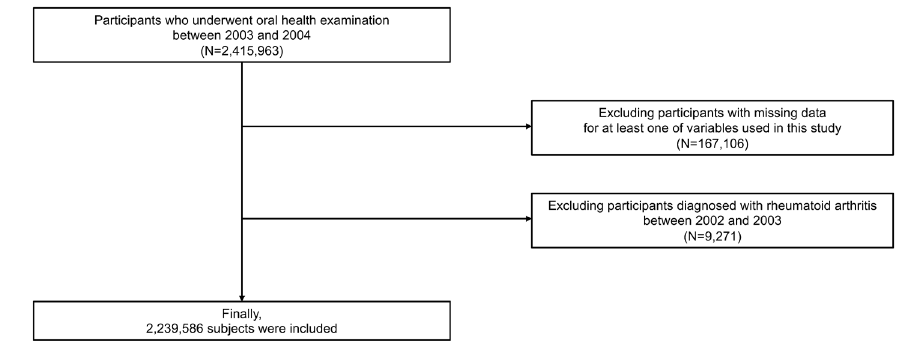
Figure 1. Flowchart of study